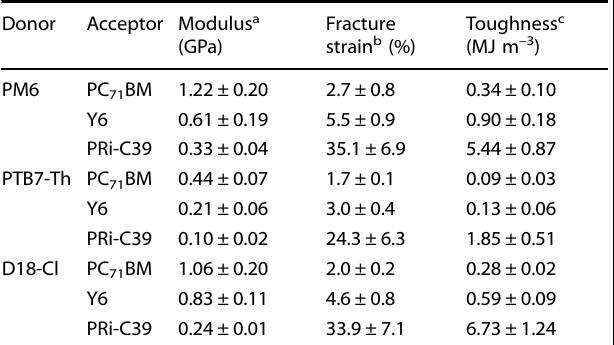
a Derived from the linear regime of the stress-strain curves using the Hooke ’ s law. b Obtained from the stress at failure. c Calculated by integrating the area under the stress-strain